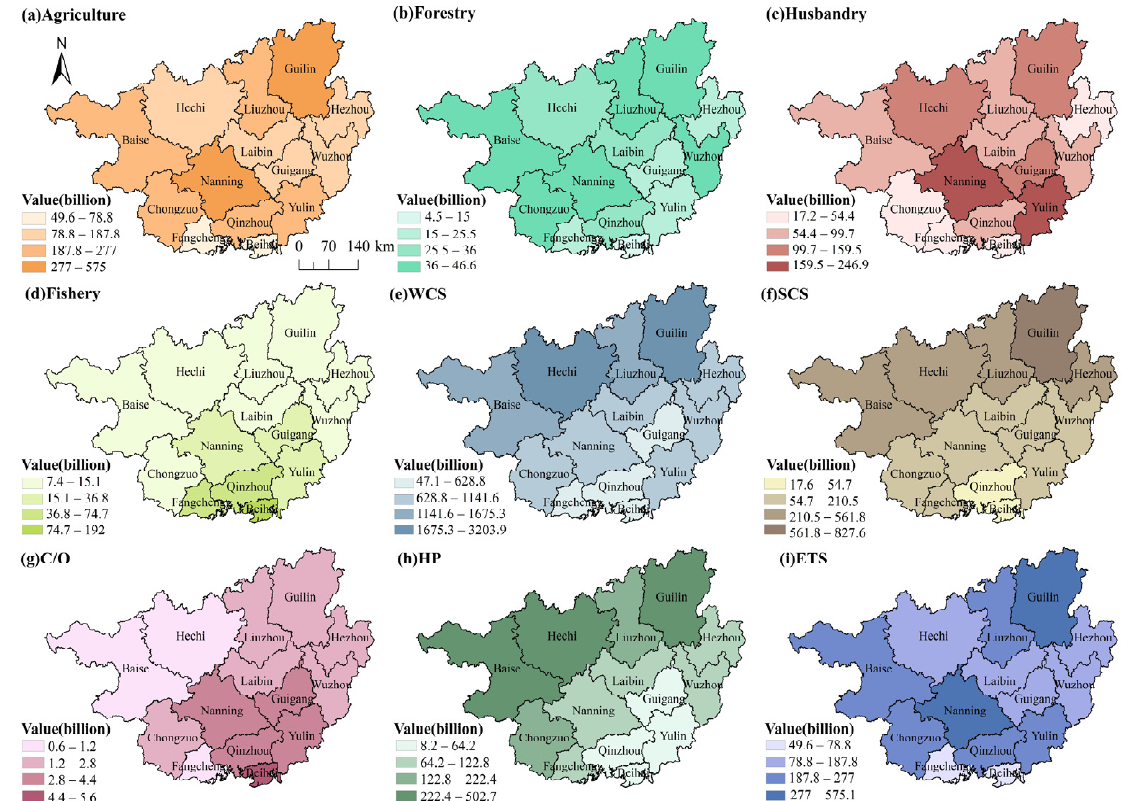
Figure 4. Spatial distribution of sub-indicators in 2020.